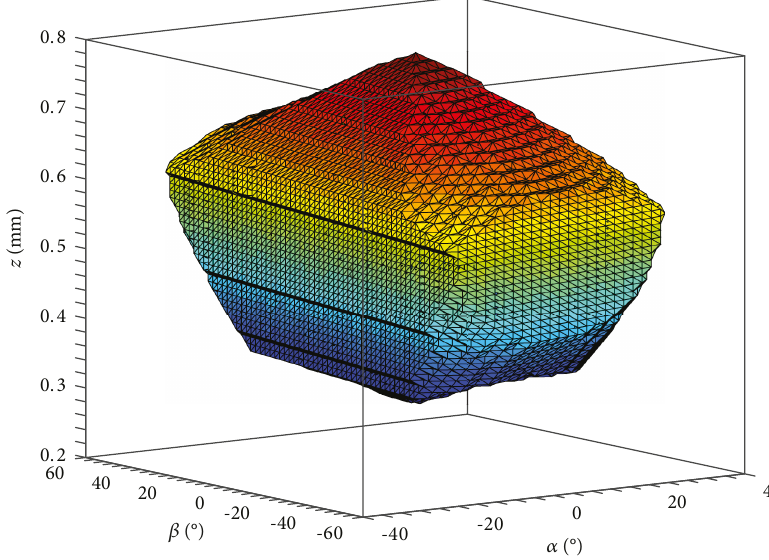
Figure 11: The operation workspace of the parallel manipulator.